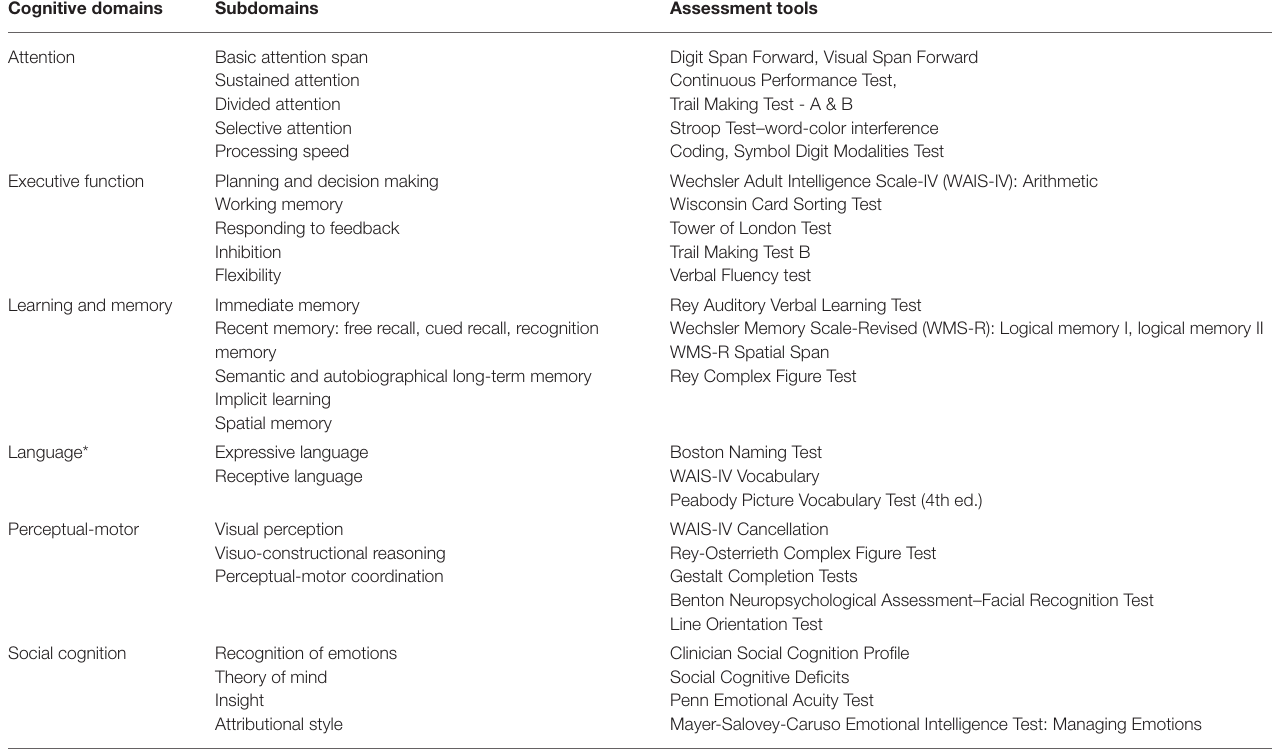
TABLE 1 | Main cognitive